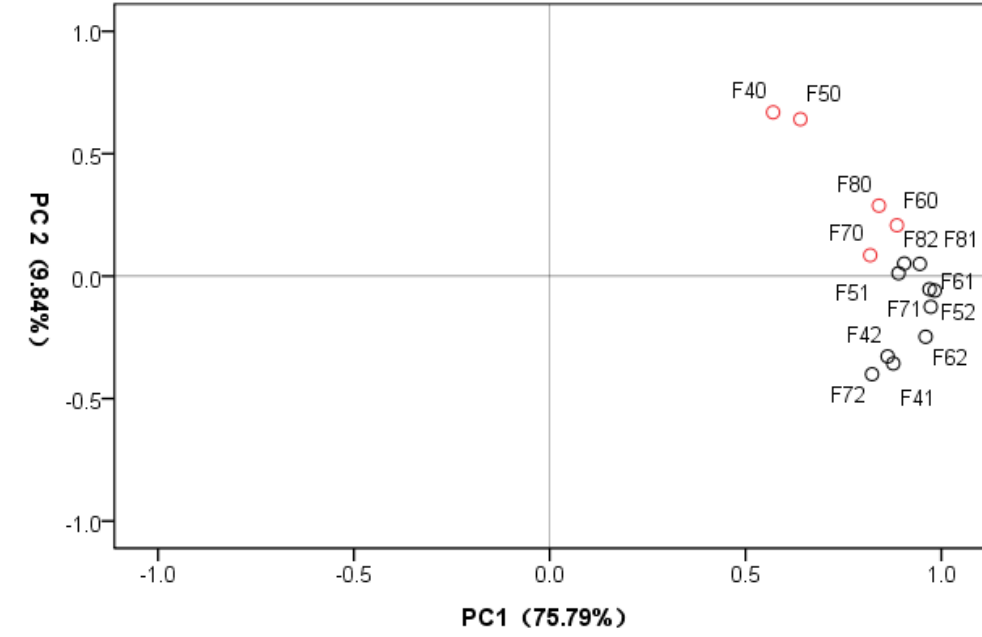
Figure 2. Principle component analysis (PCA) score plot of first and second PCs from 15 fermentation broth samples. PC1: the first principal component; PC2: the second principal component. Red and black colors represent control and Se-treated samples, respectively.